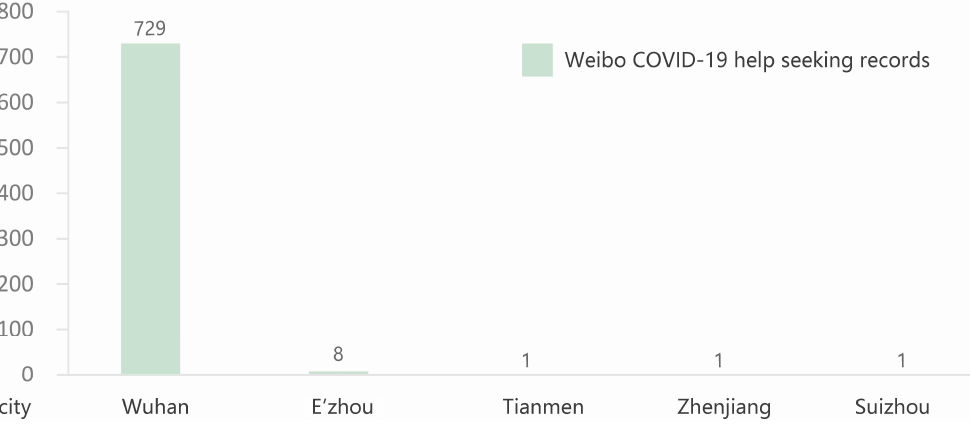
Figure 3. The distribution of Weibo COVID-19 help seeking records. Table 1. Case statistics of Wuhan.